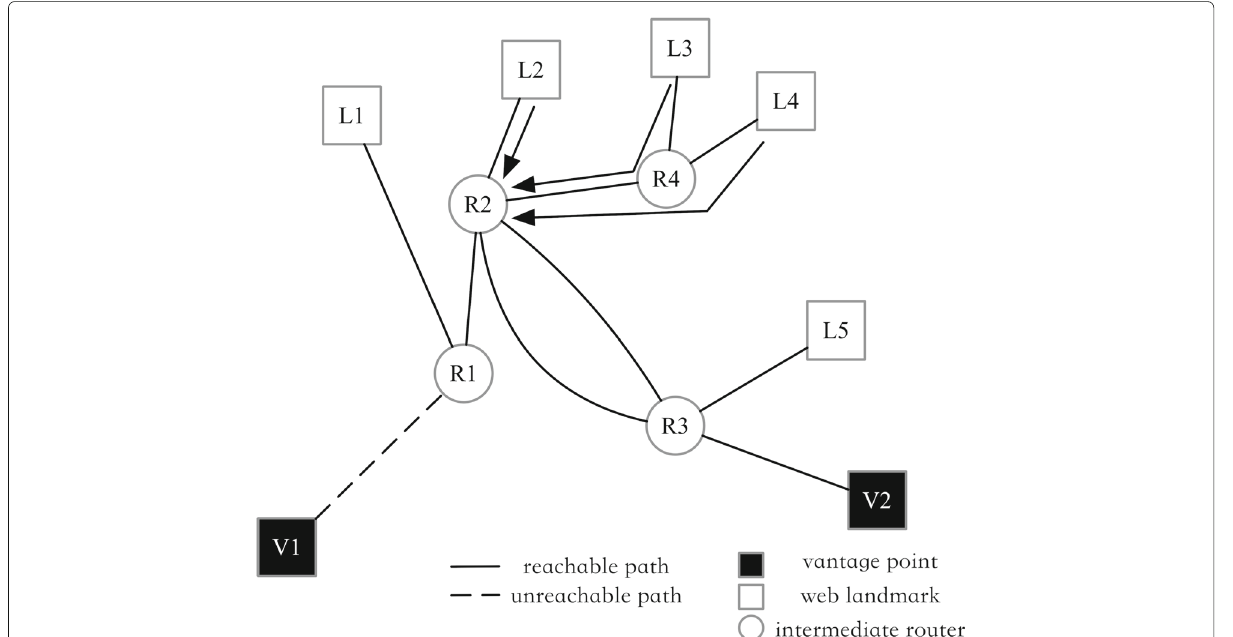
Fig. 4 Reverse locate intermediate router by